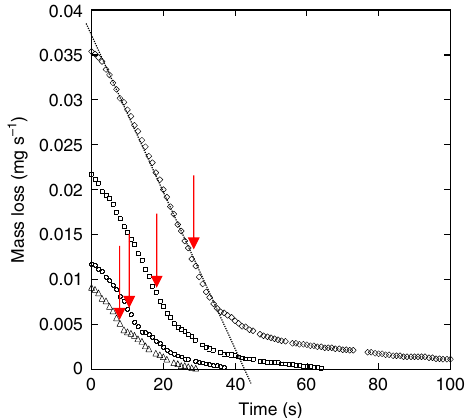
Fig. 9 Mass loss during the evaporation of DCM drops with 0.5 mmoll − 1 CTAB in a 7 cm Petri dish. Initial drop volumes from bottom to top are 6, 9, 16.6, and 26.5 µ l, respectively. Arrows indicate the time at which the drop disappears. The dotted line is used to determine the evaporation